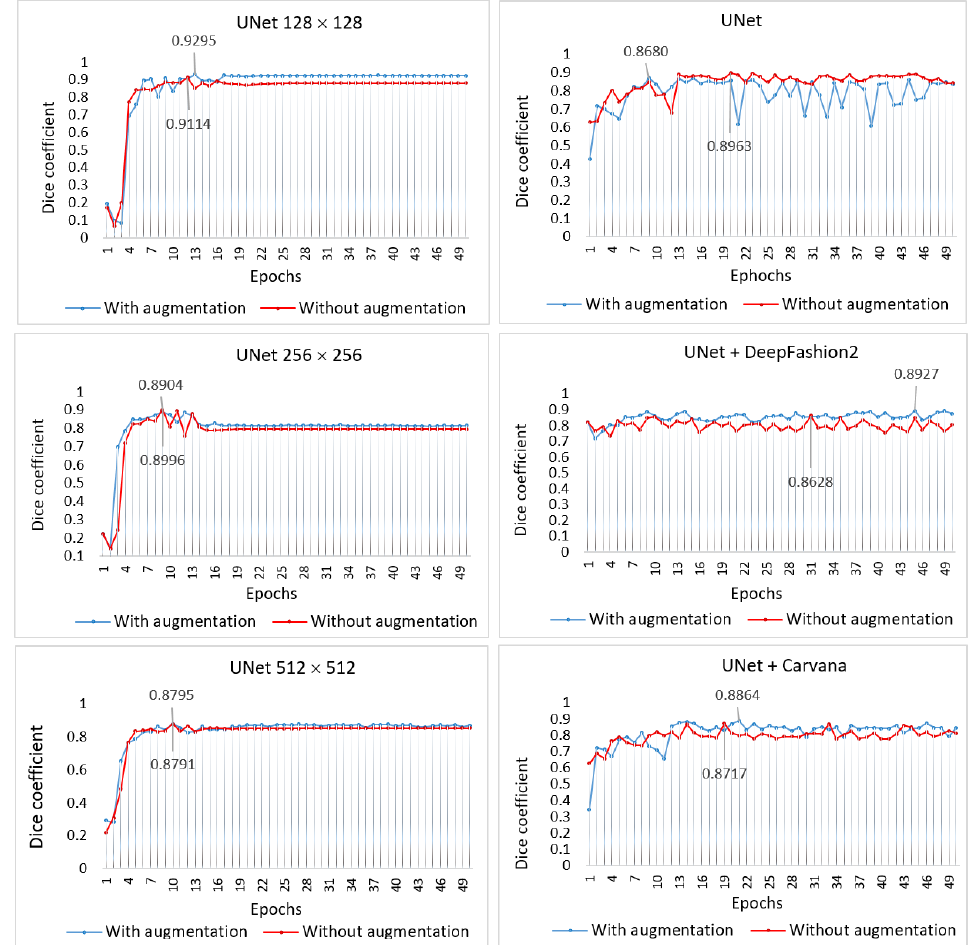
Figure 5. Dice coefficient value variation during the training process of different UNet architectures (with augmentation and without denoted maximum coefficient values).